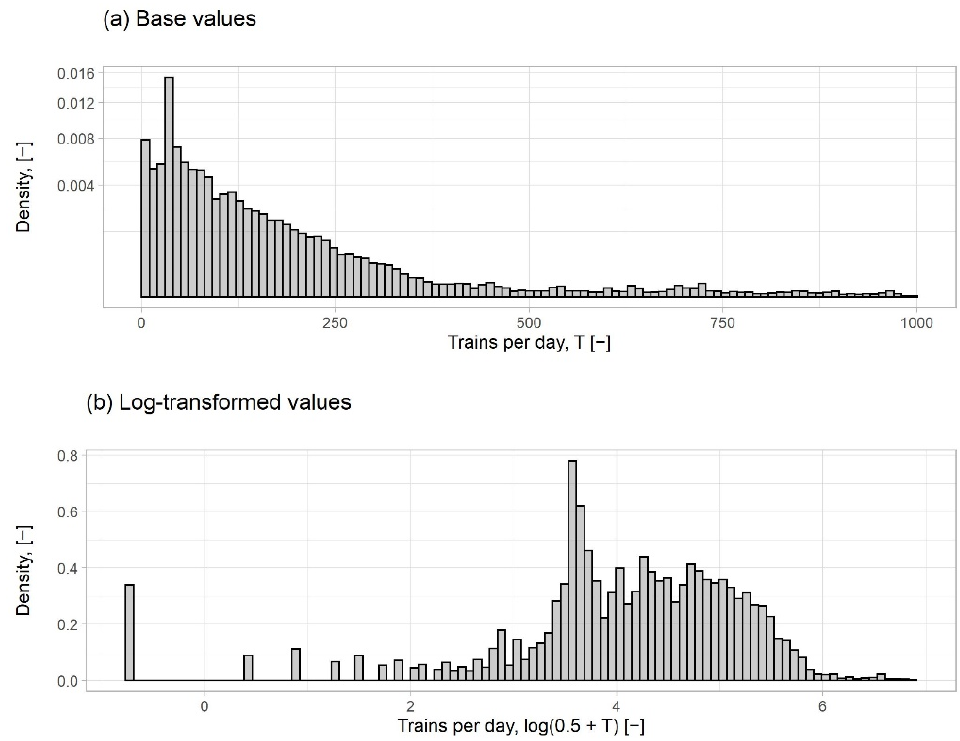
Figure 1. Histogram of daily train counts per day for a track segment with: ( a ) base values of trains per day and ( b ) log-transformed values of trains per day.